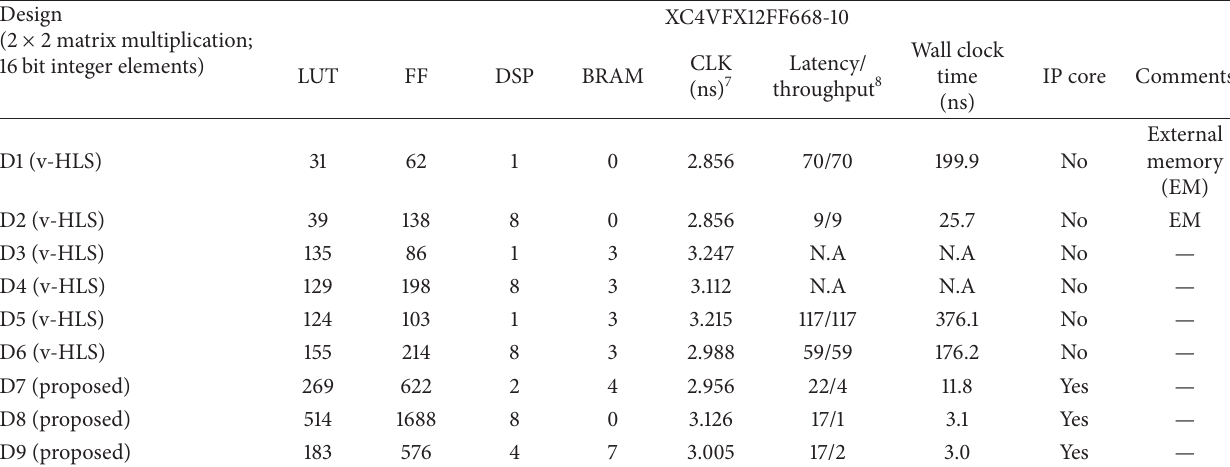
Table 8: Mapping of Matrix Multiplication Operation.